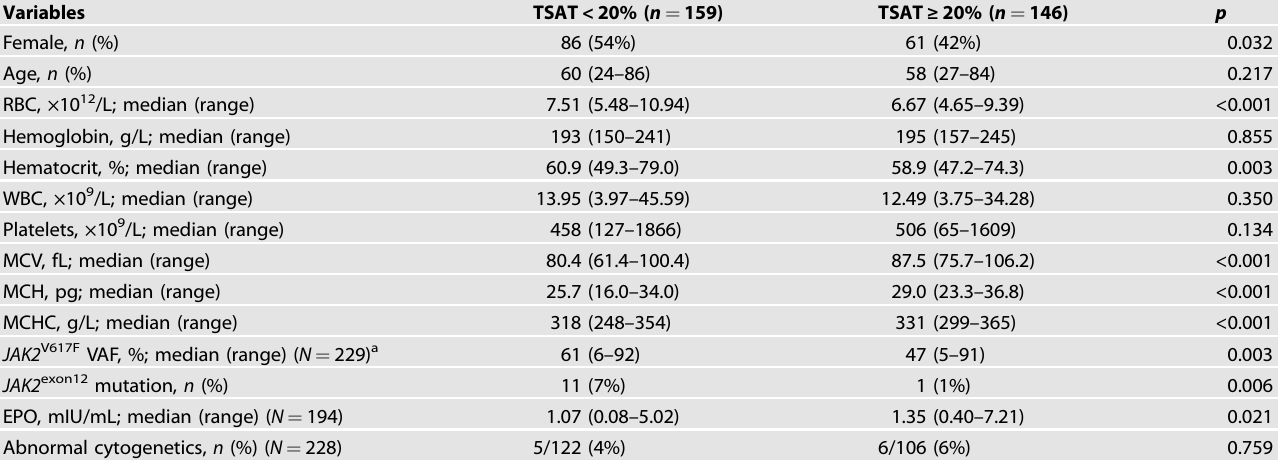
Table 1. Co-variates of PV patients with and without TSAT < 20% at diagnosis. Variables TSAT < 20% ( n =